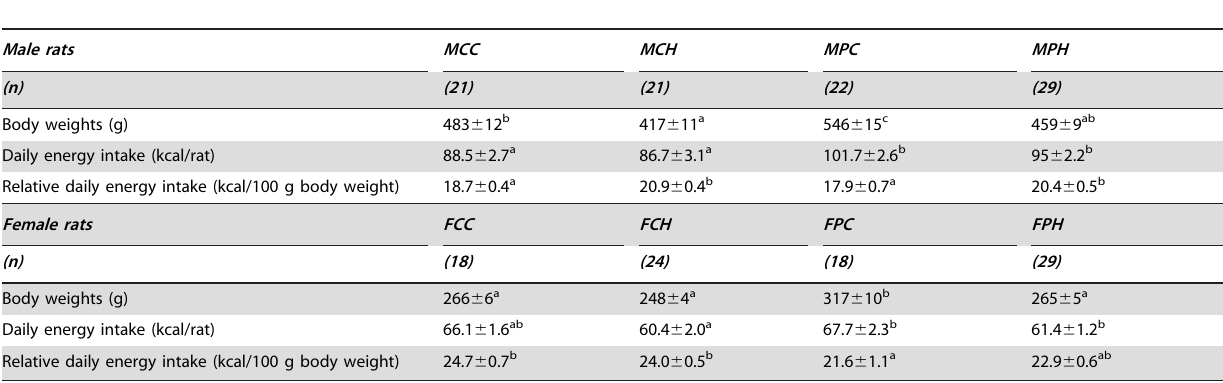
Table 5. Daily energy intake (calculated by animal and by 100 g body weight) in male and female 16 week-old rats (2 or 3 by cage), after 4 weeks feeding the palatable P diet or maintained on the chow C diet since weaning (P or C, respectively as 2 nd letter), according to the maternal chow or high-fat diet (C or H, respectively as 3rd